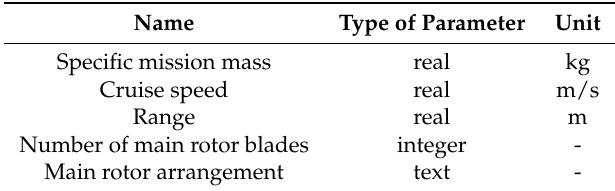
Table 1. Minimum TLARs to start the